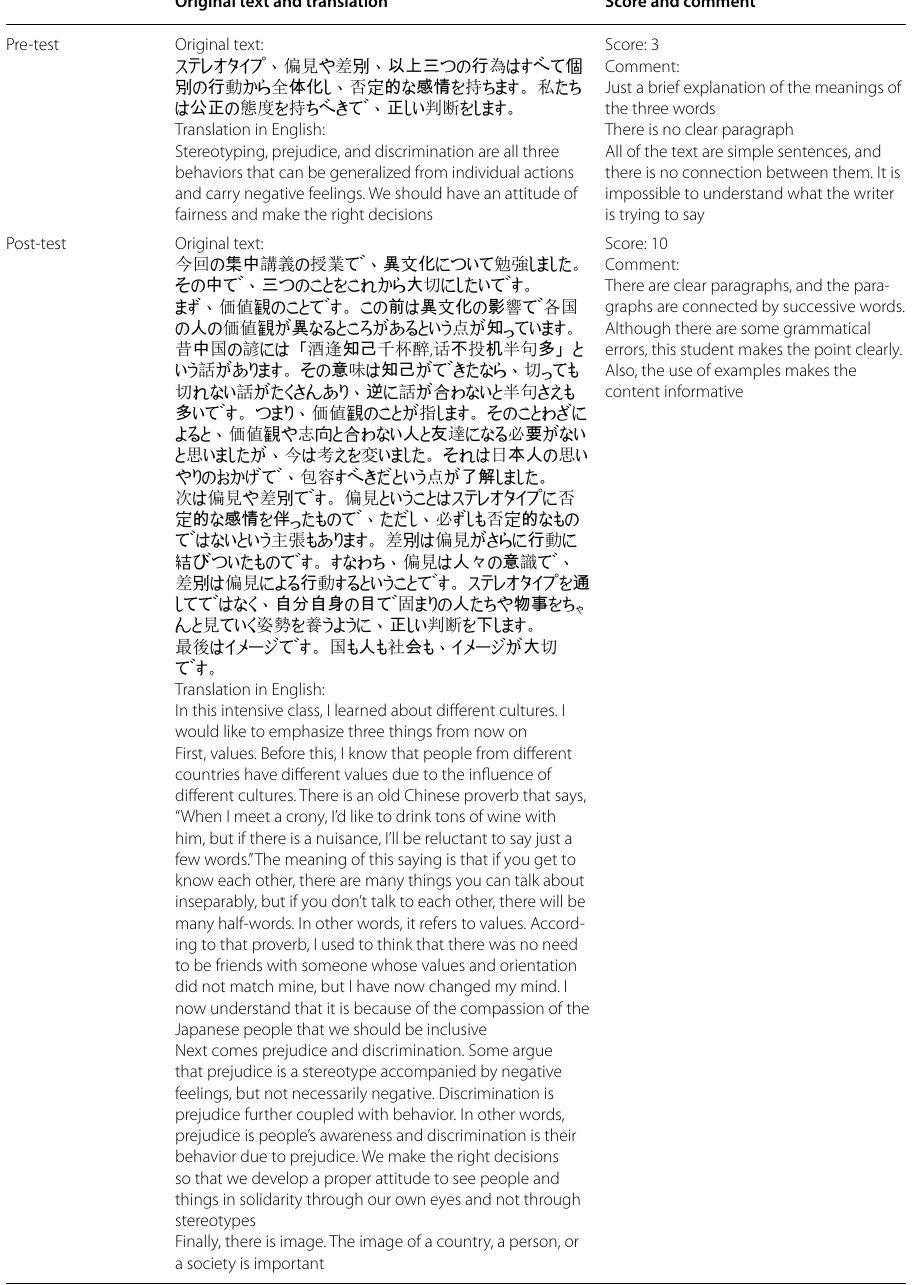
Table 7 Examples of students’ pre-post of Writing Test Original text and translation Score and comment